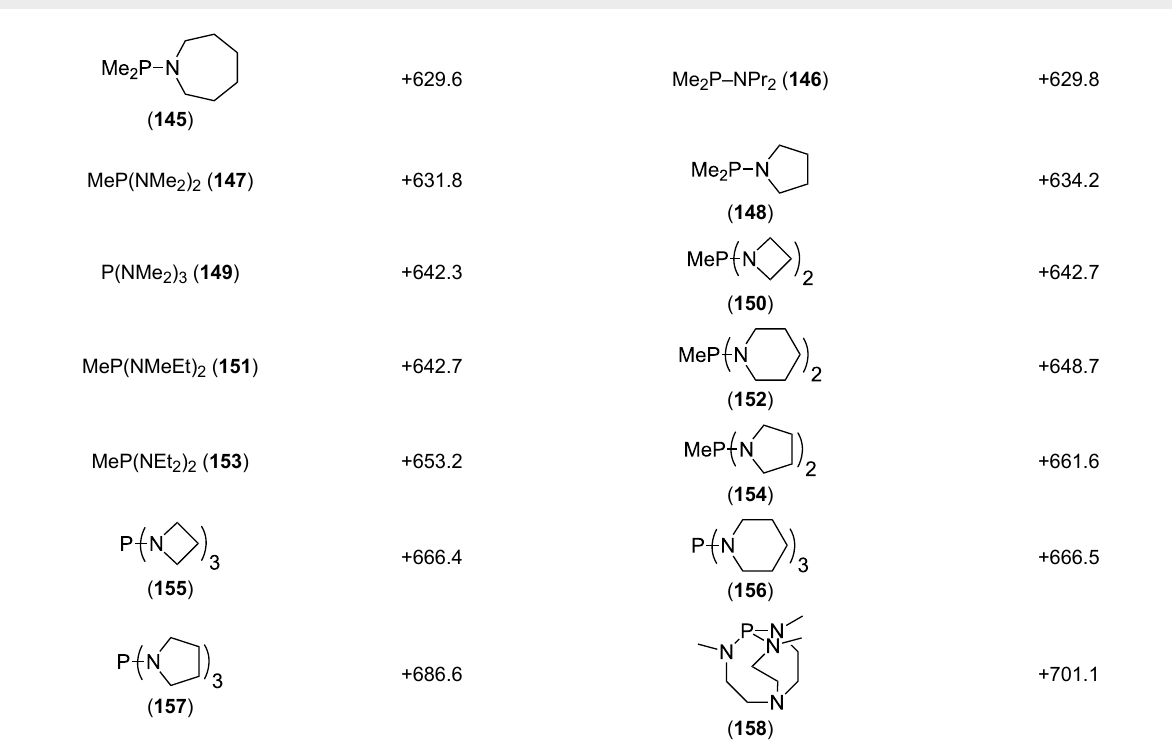
Table 3: MCA values of phosphanes containing one to three P–N bonds, ordered by increasing MCA values. (continued)